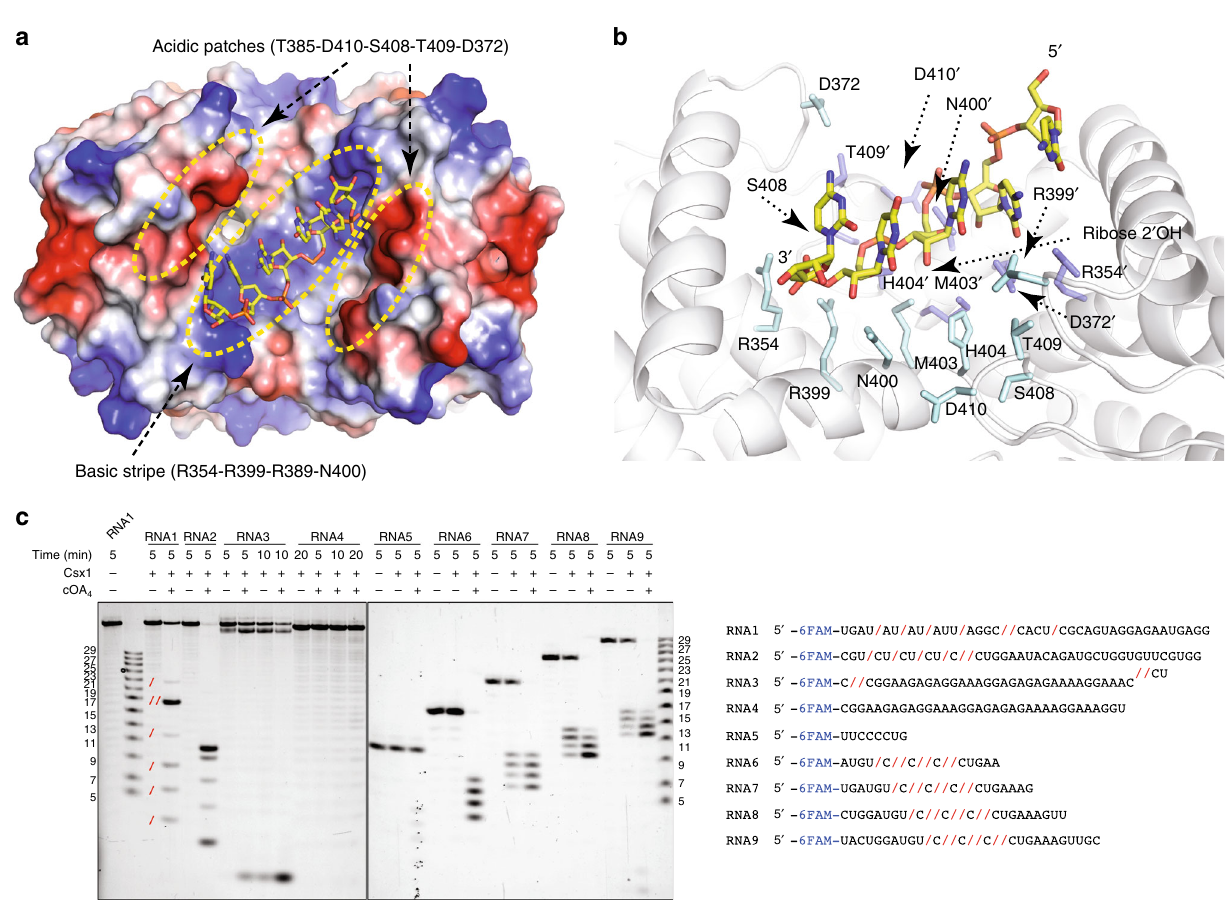
Fig. 6 Catalytic pocket of SisCsx1 in the HEPN domains and cleavage speci fi city. a Docking of polyC ssRNA (stick model) into the catalytic pocket of a SisCsx1 dimer. b The docked polyC molecule and the positioning of the 2 ′ -OH of ribose with respect to one of the H404 residues for the initiation of phosphodiester hydrolysis. Residues from each monomer are displayed in cyan and blue respectively. The residues in the later one is labelled with ´. c SisCsx1 shows a strong preference for the hydrolysis of phosphodiester bonds between 5 ′ -C – C-3 ′ located in the central section of ssRNA, as determined by activity assays using RNA1 – RNA4. The substrates are at least 9 – 12-nt-long, as determined by activity assays with RNA5 – RNA9. Red slashes in the gel and ssRNA substrates (below the gel), the cleaved bond. The experiment has been repeated three times. Source data are provided as a Source Data fi le for Fig.